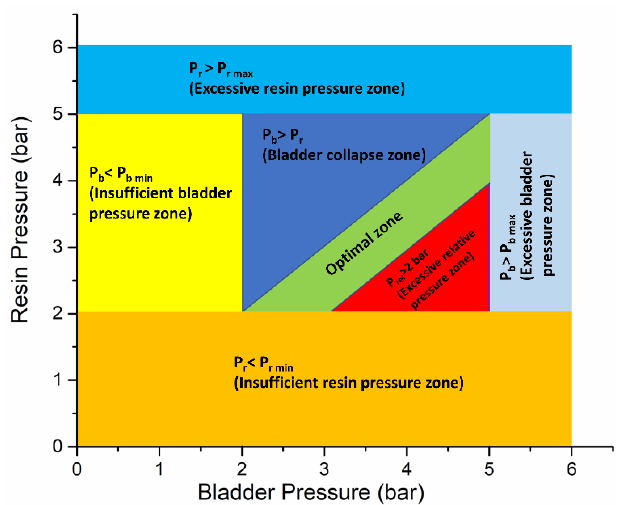
Figure 16. Manufacturing optimization zone diagram at different pressure boundary conditions during B-RTM process.